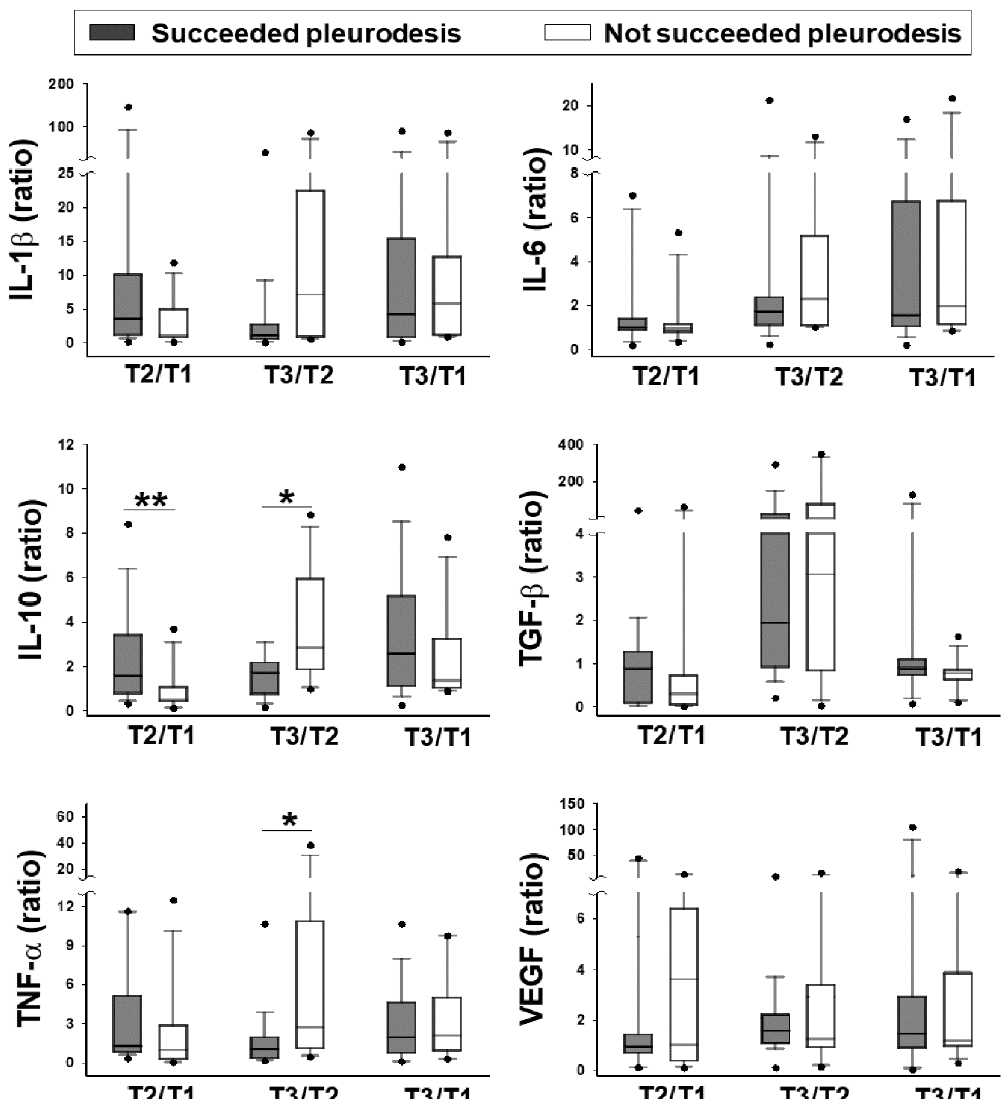
Figure 3. Fold change of the cytokines in the pleural fluid. IL-1β, IL-6, IL-10, TGF-β, TNF-α, and VEGF levels measured at the later time points were divided by those measured at the earlier time points and compared between patients who underwent successful pleurodesis (grey column; n = 19) and those not succeeded (white column; n = 12). Box plots demonstrated the ratios. The dots represent the 5th and 95th percentiles, respectively. The error bars cover the 10th to 90th percentiles and the box covers the 25th to 75th percentiles. The line within the box represents the median value. T1, before pleurodesis; T2, three hours after pleurodesis; T3, 24 h after pleurodesis; * p < 0.05; ** p < 0.01.